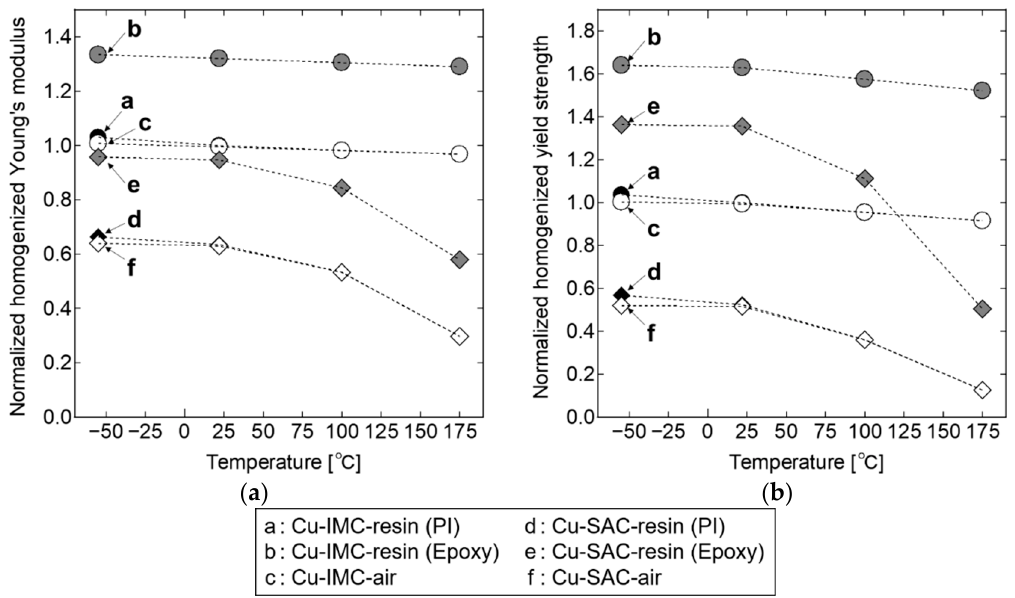
Figure 5. Temperature dependence of the homogenized ( a ) Young’s modulus and ( b ) yield strength calculated by the 15- μ m-sized models of Cu-IMC-resin and Cu-SAC-resin, where the resin region is PI, epoxy, or air. The values are normalized by that of the Cu-IMC-resin (PI) at 22 °C.